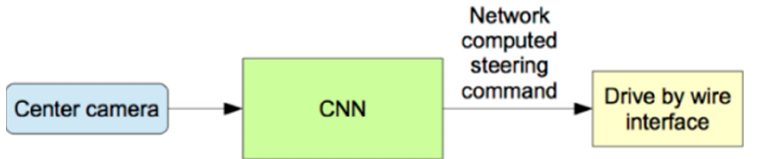
Figure 5. Testing the neural network.